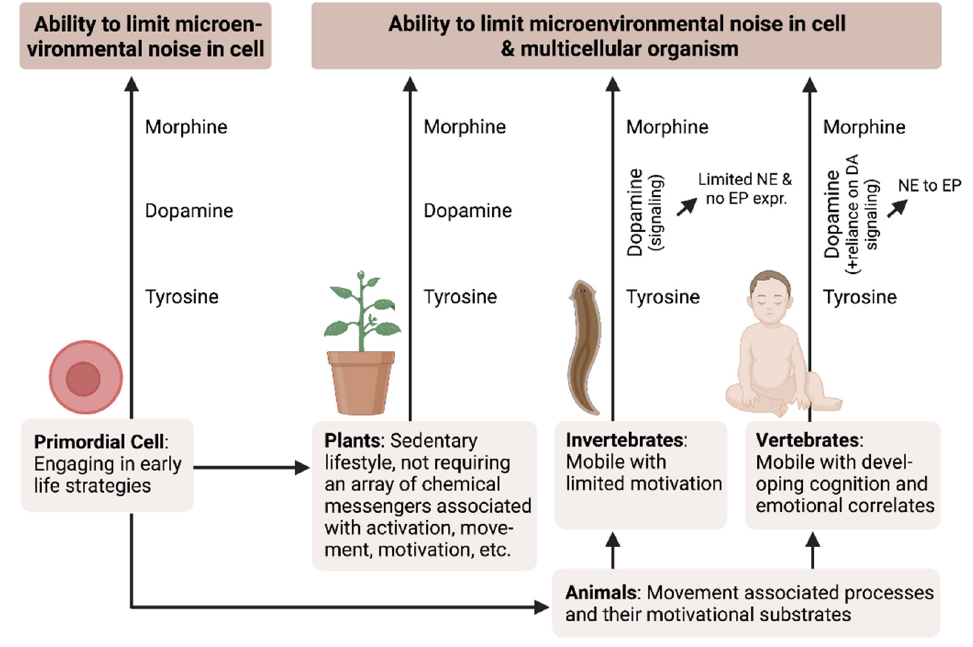
Figure 1. Changes observed in response to evolutionary constraints. While dopamine (DA) may be detected in plant and primordial cells, these systems do not rely on catecholamine signaling pathways. By contrast, DA is a prominent signaling agent in invertebrate animal species. In certain com- paratively long-lived invertebrates, DA is modified to generate dopamine ß-hydroxylase. In verte- brates, the morphine biosynthetic enzyme, catechol O-methyl transferase (COMT), has been “retro- fitted” and facilitates the conversion of norepinephrine (NE) to epinephrine (EP). This relationship is further highlighted by observations documenting the colocalization of catecholamine with endog- enous morphine in the brain. Of note, DA has been identified as an endogenous morphine precur- sor; likewise, morphine-induced constitutive NO serves to downregulate excitatory processes and scavenge free radicals that result at least in part as a byproduct of catecholamine signaling (refer- ences: [1,2,10–21]). 2. Morphine and Dopamine as Signaling Molecules 2.1. Evolutionary Significance of Catecholaminergic Signaling The maturation and release of morphine and benzylisoquinoline (BIQ) alkaloids take place in P. somniferum cells. DA is used exclusively in plant species as a substrate for Pictet- Spengler condensation with tyramine aldehyde to generate norcoclaurine, which is the first committed chemical intermediate in morphine biosynthesis [22–36]. All invertebrate phyla retain the capacity to synthesize morphine [10,11,37]. How- ever, catecholamines (including DA) have emerged as signaling molecules in numerous invertebrate organ systems [12,13,38,39]. We were unable to detect epinephrine (EP) in invertebrate tissues; this result suggests that sequential methylation and hydroxylation of DA leading to the formation of EP developed later during evolution. By contrast, the cat- echolamine pathway has undergone extensive development in vertebrate species and ter- minates in the biosynthesis of EP [14]. In our previous publications, we highlighted the emergence of DA as a prototype signaling molecule and discussed its critical role in dopaminergic/catecholaminergic sig- naling pathways [2]. As noted above, while both plants and animals can synthesize mor- phine, the catecholamine pathway and regulated expression of EP exist only in vertebrate species. These findings suggest that catecholamine and related signaling systems emerged from the morphine-based pathway via the adaptation of enzymes involved in L-TYR, levodopa (L-DOPA), DA, and tyramine modification [1,2,11,15]. Morphine promotes the downregulation of tissue excitability via interactions with specific receptors (see below),